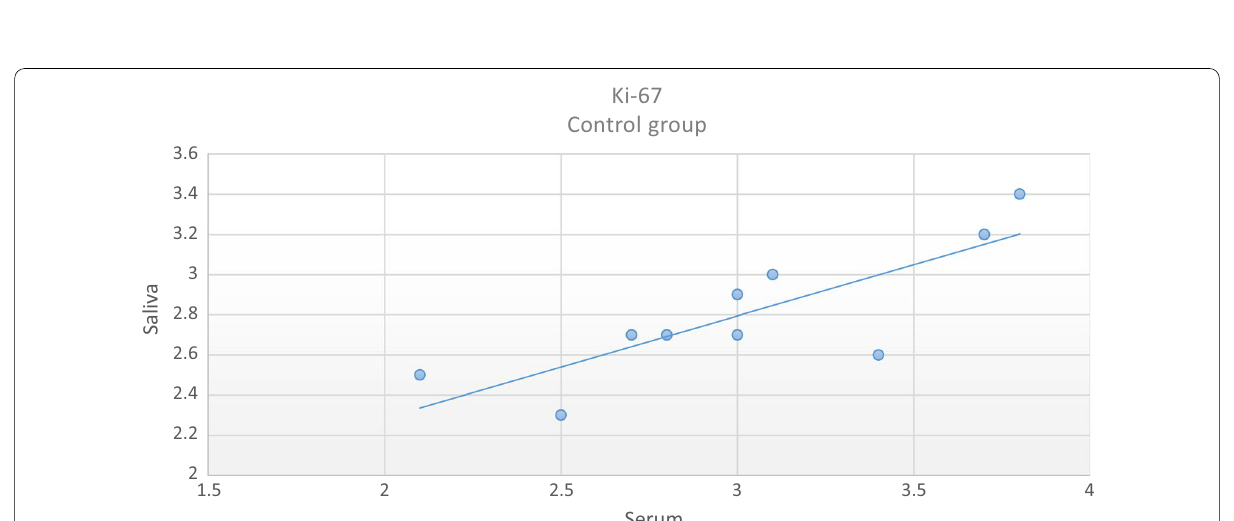
Fig. 14 Correlation between serum and saliva Ki-67 expression in control group as determined by Pearson’s correlation coefficient